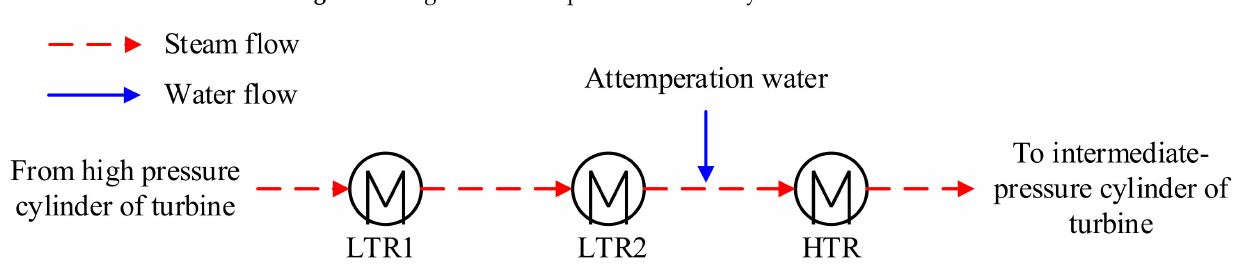
Figure 1. Diagram of the superheated steam system.